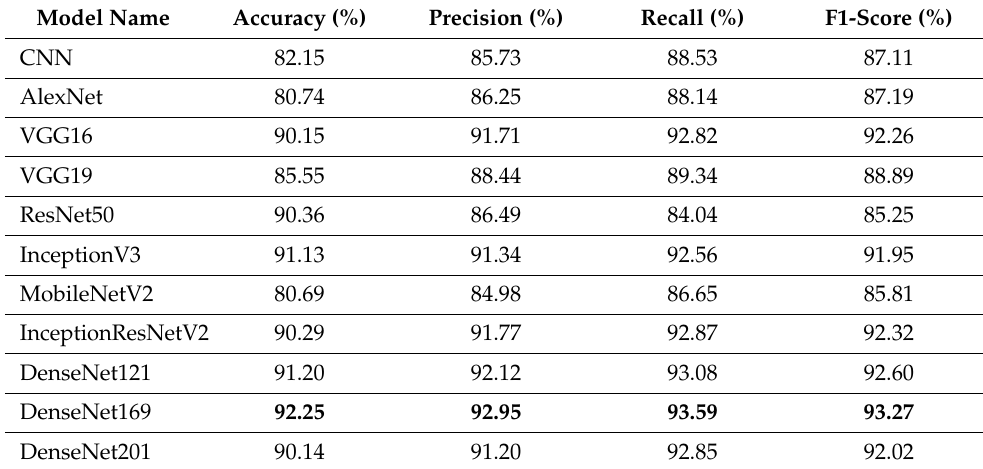
Table 3. Average values of metrics for the tested models.